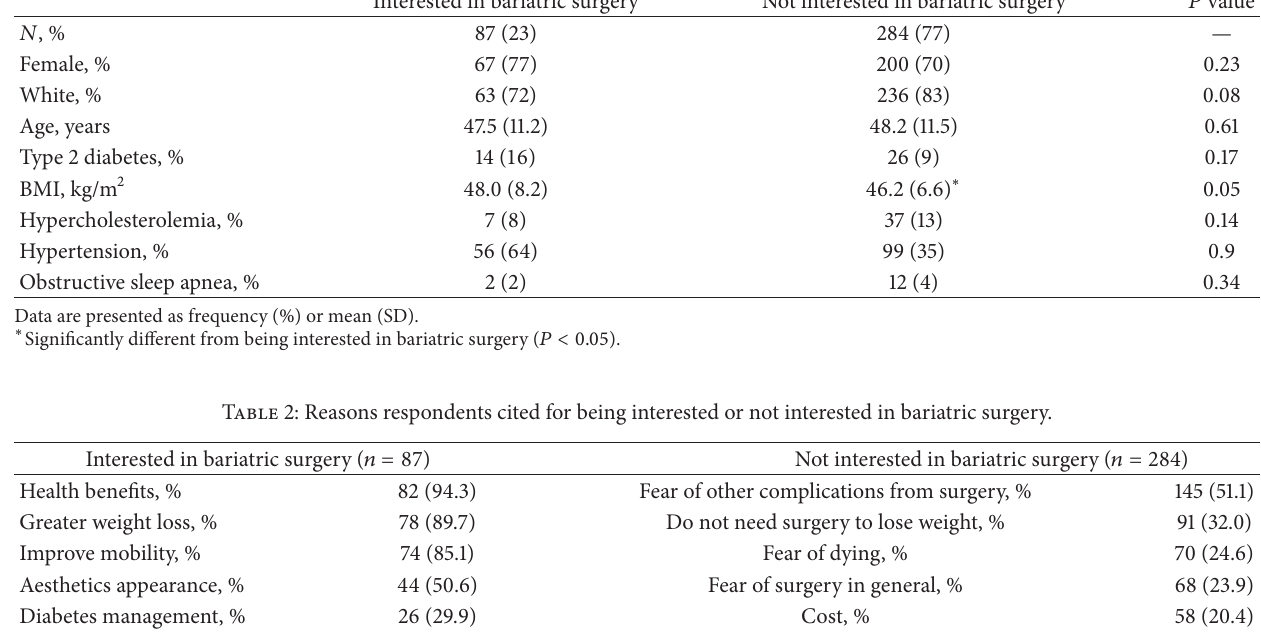
Table 1: Respondent characteristics in 371 patients of the Wharton Medical Clinic who qualify for bariatric surgery. Interested in bariatric surgery